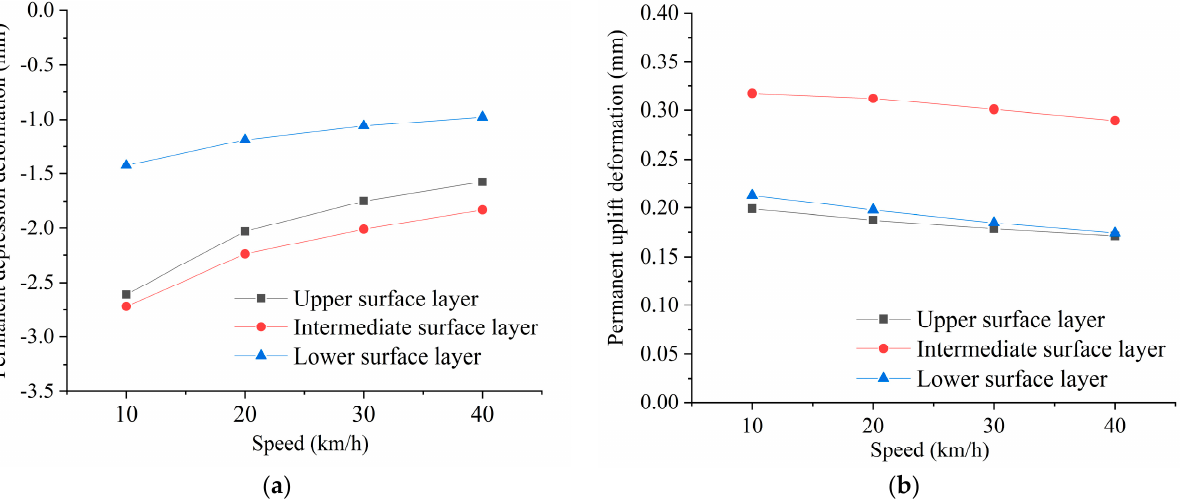
Figure 19. Variation in permanent deformation of each structural layer with vehicle speed: ( a ) depression deformation; ( b ) uplift deformation.